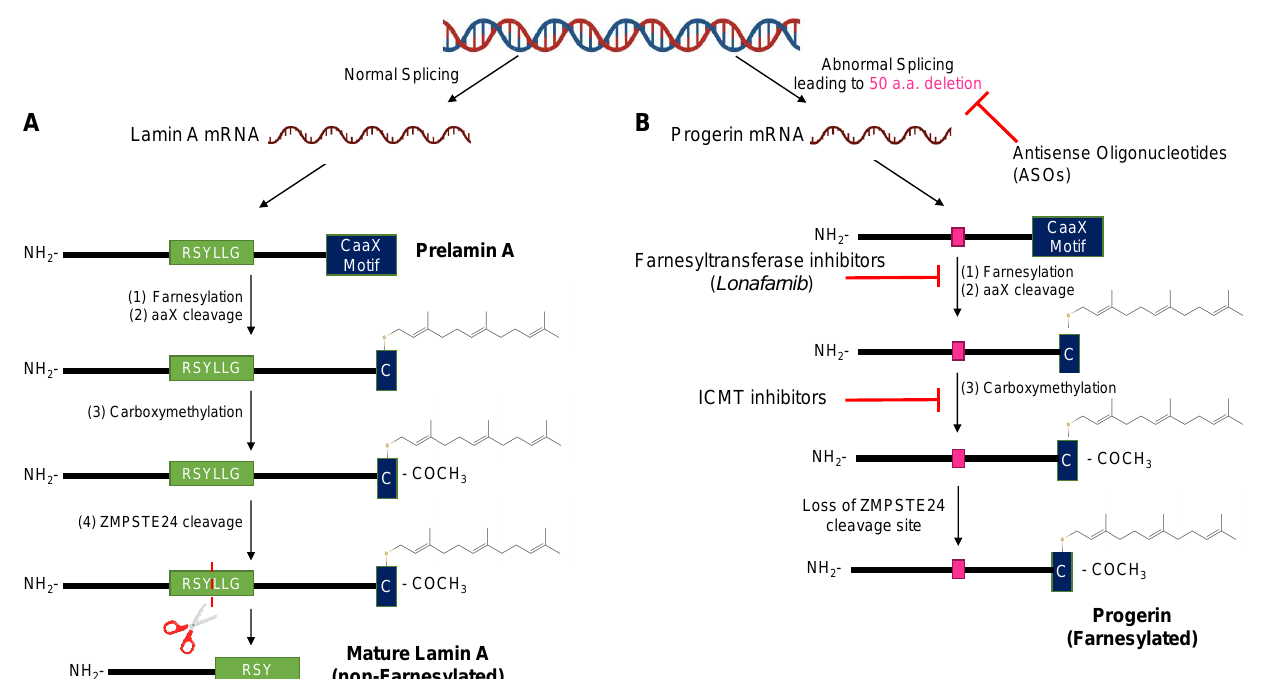
Figure 2. The differences between processing/modifying a normal prelamin A protein and the progerin mutant. ( A ): Normal splicing generates a prelamin A protein, which has a terminal CaaX box. The “C” denotes cysteine, “a” is an aliphatic residue, and “X” is any amino acid. The cys- teine residue is initially prenylated by a 15-carbon isoprenoid unit. Subsequently, the aaX motif is cleaved by ZMPSTE24, and then a carboxyl-methyl group is added by isoprenylcysteine carboxyl- methyltransferase (ICMT). The final cleavage step is performed by ZMPSTE24, removing 15 amino acids from the C-terminal region including the farnesylated cysteine. ( B ): 1824 (C>T) mutation at the human LMNA gene generates a cryptic donor splice site. The cryptic donor splice site is improperly recognized by the spliceosome, leading to a 50 amino acid (a.a.) deletion in the prelamin A protein including the ZMPSTE24 cleavage site (pink rectangle). The next few steps mirror normal lamin A production. The final ZMPSTE24-mediated step does not occur due to absence of the ZMPSTE24 cleavage site, resulting in a permanently farnesylated and carboxyl-methylated